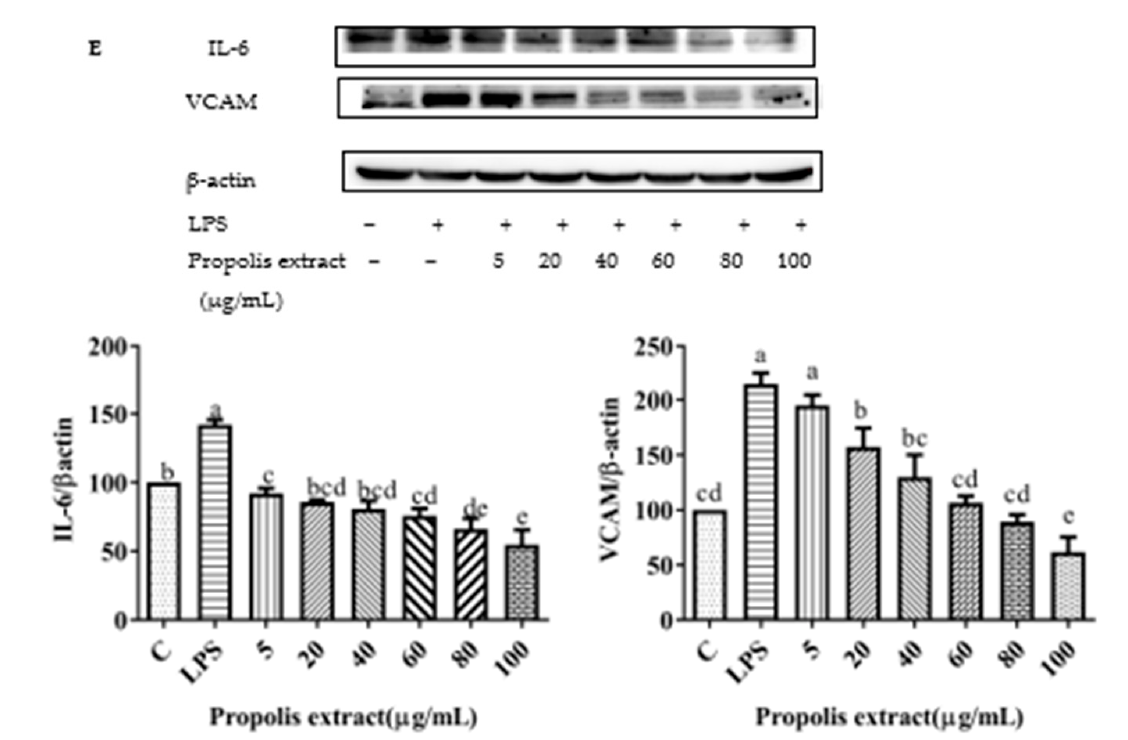
Figure 10. Expression of pro-inflammatory cytokine proteins (VCAM1 and IL-6) induced by individ- ual flavonoids (chrysin, pinocembrin, galangin, and pinobanksin) and propolis extract in 10 µ g/mL LPS-induced H9c2 cells. H9c2 cells were stimulated with different concentrations of phytochemicals (chrysin, pinocembrin, galangin, pinobanksin, and propolis extract) for 12 h and then treated with 10 µ g/mL LPS for 12 h; finally, the expression of pro-inflammatory cytokine proteins (VCAM1 and IL- 6) was detected via Western blot. ( A ) Expression of pro-inflammatory cytokine proteins (VCAM1 and IL-6) in chrysin-induced H9c2 cells. ( B ) Expression of pro-inflammatory cytokine proteins (VCAM1 and IL-6) in pinocembrin-induced H9c2 cells. ( C ) Expression of pro-inflammatory cytokine proteins (VCAM1 and IL-6) in galangin-induced H9c2 cells. ( D ) Expression of pro-inflammatory cytokine proteins (VCAM1 and IL-6) in pinobanksin-induced H9c2 cells. ( E ) Expression of pro-inflammatory cytokine proteins (VCAM1 and IL-6) in propolis-extract-induced H9c2 cells. Values are expressed as the mean ± SEM ( n = 3). Values with different letters (a, b, c, d, e, f) in the figure showed significant differences at p <